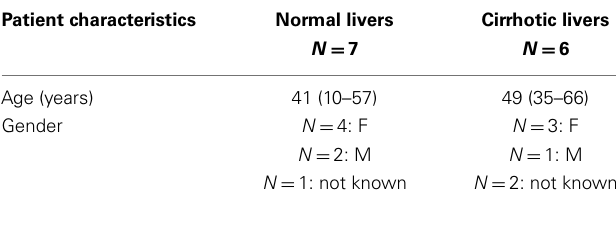
Table 1 |Available patient characteristics of the used human livers